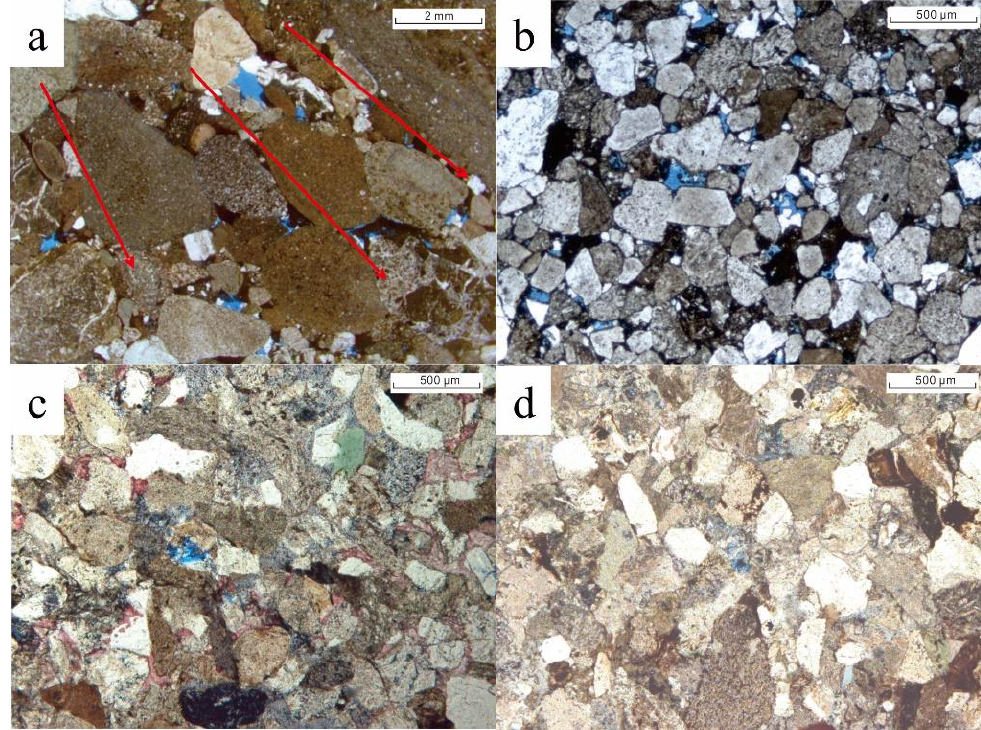
Figure 4. Cast thin sections of compaction in study area. ( a ) well YT1, 4821.9 m, Lower Wuerhe formation, sandy conglomerates, grains in close contact, line contact – concavo – convex contact; ( b ) well YT1, 4810 m, Lower Wuerhe formation, medium sandstone, grains in close contact, line contact – concavo – convex contact; ( c ) well MZ4, 3580 m, grains in close contact, sutured contact; ( d ) well M18, 3438.3 m, grains in close contact, sutured contact.